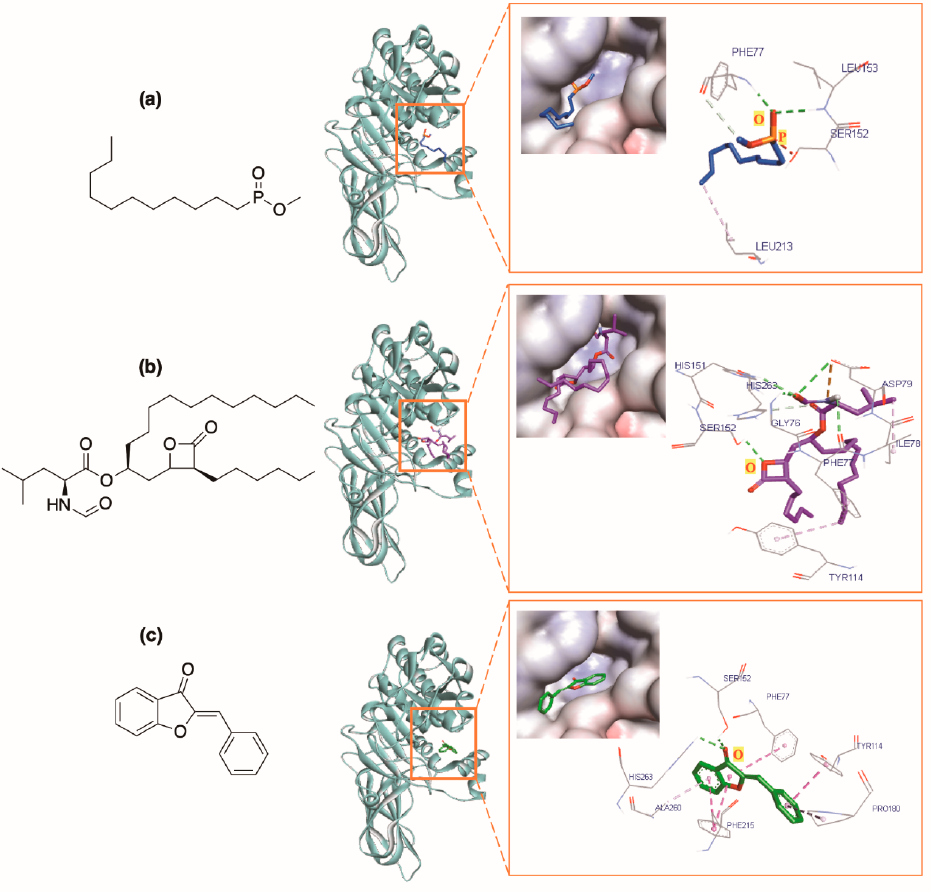
Figure 3. Docking results with protein (PDB ID: 1LPB) of ( a ) co-crystallized ligand MUP, ( b ) orlistat, and ( c ) general structure of aurones ( A0 ). Lipase in blue, lipase active site residues in stick model.